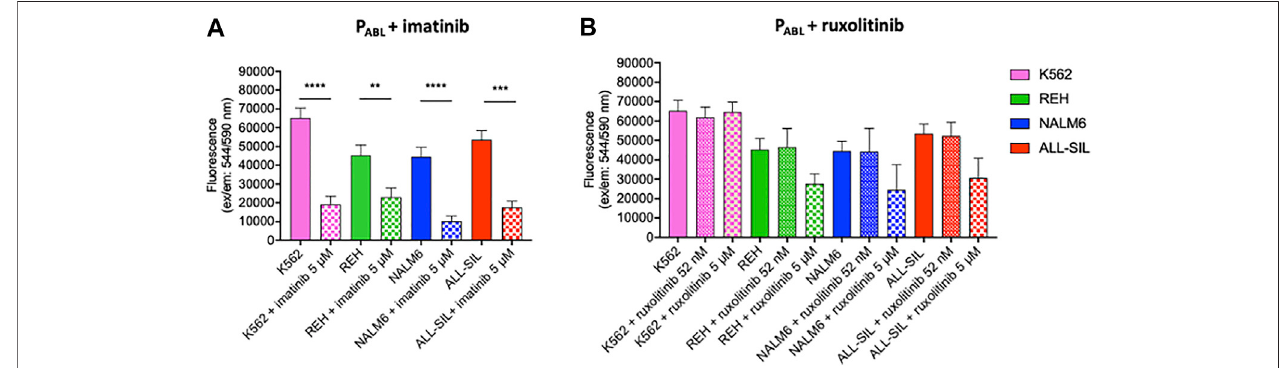
FIGURE 6 | P ABL -based ELISA assay in the presence of (A) imatinib and (B) ruxolitinib. Fluorescence values in ordinate. Imatinib determines asigni fi cantdecrease ofP ABL -phosphorylationinallcelllines.ThereductionisparticularlyevidentforthosecelllineswithalterationsaffectingtheABL1-pathway(K562,andALL-SIL)andisless pronounced in REH. Ruxolitinib treatment does not affect P ABL -phosphorylation. p -value according to two-way ANOVA, Bonferroni post-test for multiple comparison: